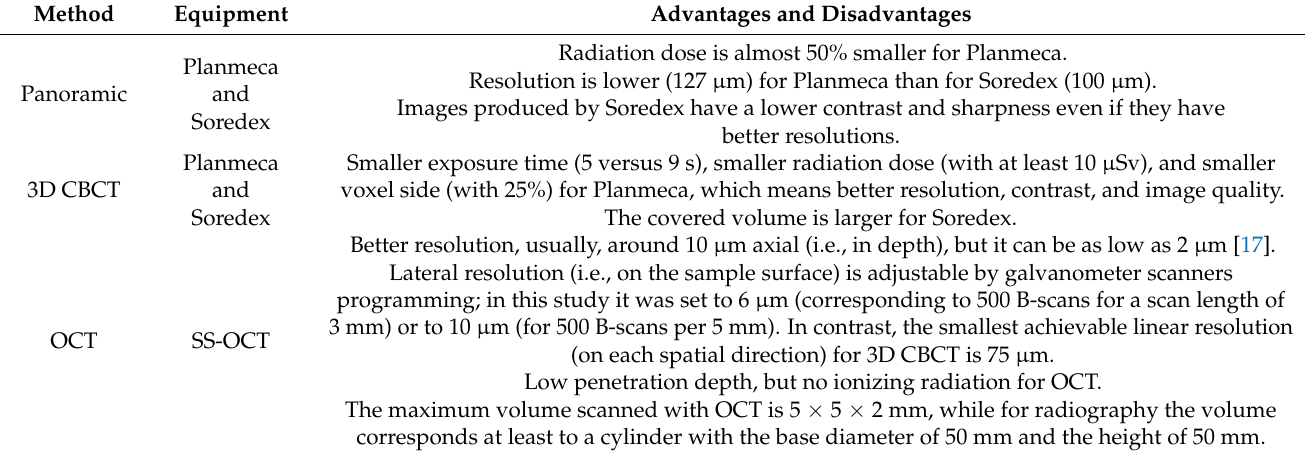
Table 7. Advantages and disadvantages of Planmeca and Soredex X-ray unit for panoramic radiographs, as well as total, segmental, and maxillary or mandible 3D CBCT. Comparison to OCT.